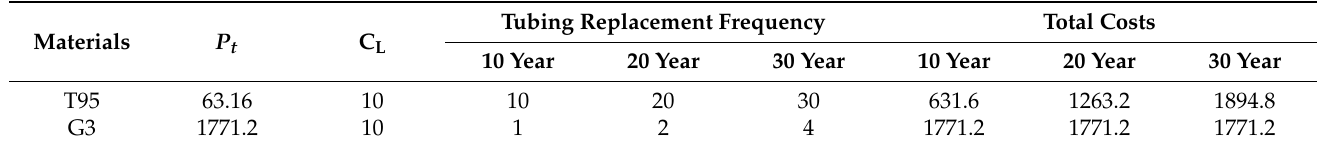
Table 5. Total costs of changing tubing in different service periods (Ten thousand yuan).